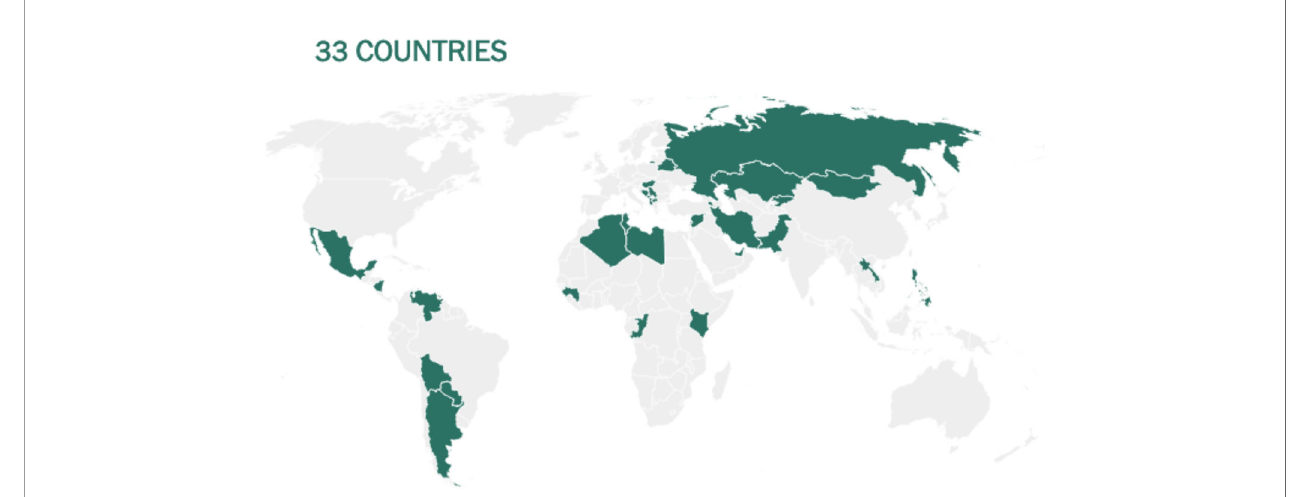
FIGURE 13 | Countries where the Sputnik V (Gamaleya) vaccine is being used as of May 10, 2021. Source: Our World in Data